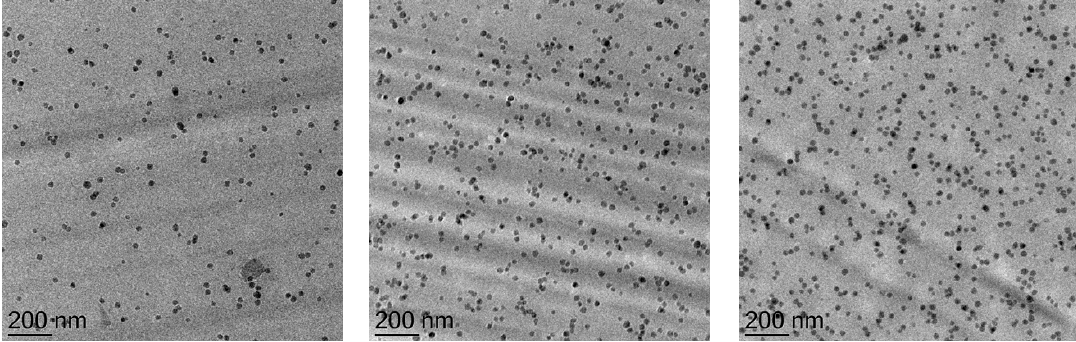
Figure 3. TEM images of nano-SiO 2 modifed epoxy resin: 0.8 vol.% ( left ), 2.3 vol.% ( middle ) and 3.9 vol.% ( right ).